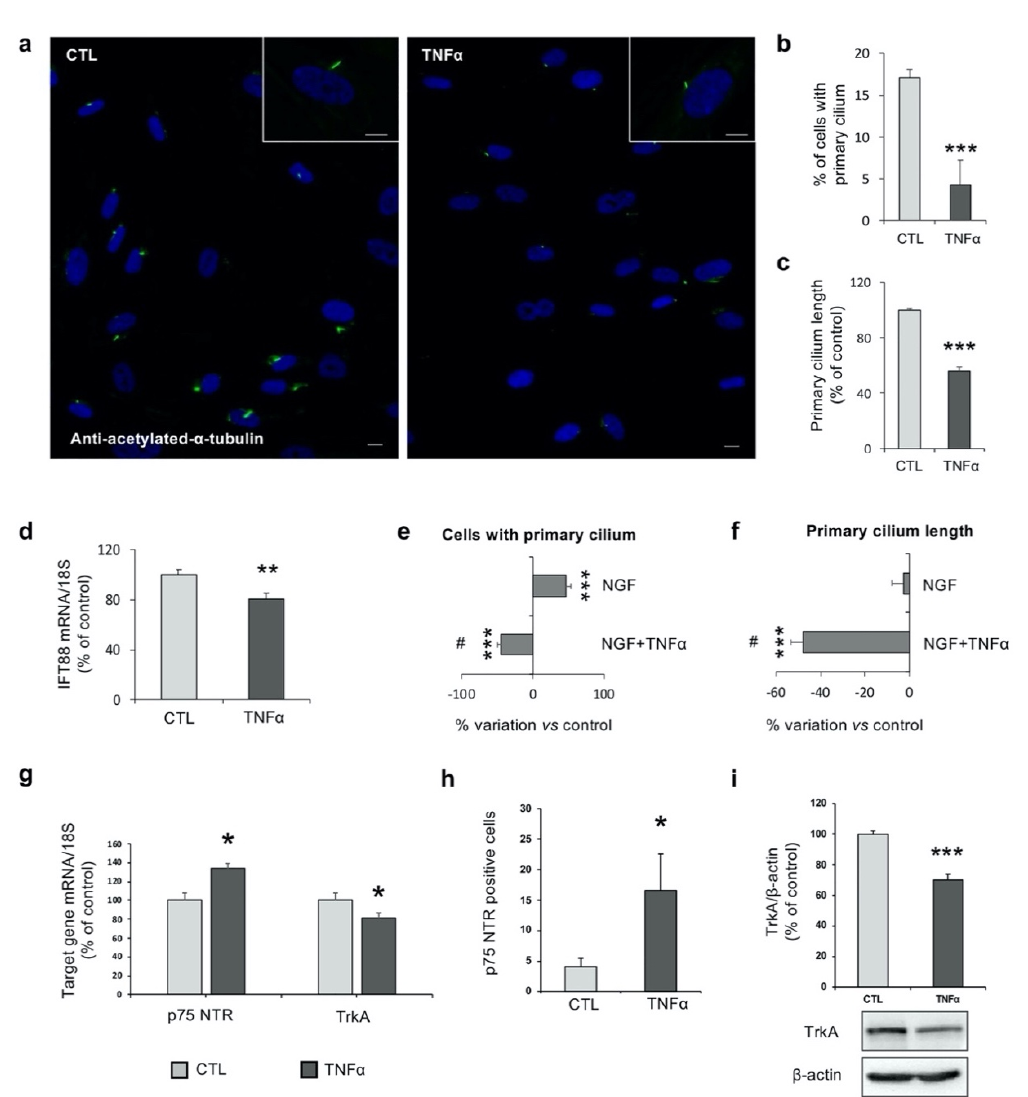
Figure 3. TNF α inhibits primary cilium formation in hfNBMs. ( a ) Representative images showing the primary cilium in untreated (CTL) or TNF α‐ treated (10 ng/mL, 24 h) hfNBMs by immunofluorescence using the specific marker acetylated α‐ tubulin (DAPI counterstained nuclei; scale bars 10 μ m). ( b ) Number of cells with a primary cilium counted in ten different fields for each condition and expressed as percentage of DAPI ‐ stained (blue) total cells. Results are reported as mean ± SEM of three separate experiments (unpaired Student’s t ‐ test; *** p < 0.001 vs . CTL; n = 30). ( c ) Evaluation of the primary cilium length performed in at least 15 cells for untreated (CTL) and TNF α‐ treated (10 ng/mL, 24 h) hfNBMs, using ImageJ NeuronJ plugin. Data are expressed as percentage of CTL and reported as mean ± SEM of three separate experiments (unpaired Student’s t ‐ test; *** p < 0.001 vs . CTL; n = 15). ( d ) IFT88 mRNA expression in untreated (CTL) and TNF α‐ treated (10 ng/mL, 24 h) hfNBMs by qRT ‐ PCR. Data are normalized over 18S ribosomal RNA subunit and reported as percentage of CTL and displayed as mean ± SEM of four separate experiments performed in triplicate (unpaired Student’s t ‐ test; ** p < 0.01 vs . CTL; n = 12). ( e ) Number of hfNBMs with a primary cilium after NGF treatment (100 ng/mL) in presence (NGF+TNF α ) or absence (NGF) of TNF α (10 ng/mL) for 24 h. Data are reported as percentage of variation of untreated cells (CTL) and displayed as mean ± SEM of four separate experiments (one ‐ way ANOVA followed by Tukey’s post hoc analysis; *** p < 0.001 vs . CTL; # p < 0.001 vs . NGF; n = 40). ( f ) Evaluation of the primary cilium length performed in at least 15 hfNBMs for NGF ‐ treated cells (100 ng/mL) in presence (NGF+TNF α ) or absence (NGF) of TNF α (10 ng/mL) for 24 h. Data are calculated using ImageJ, reported as percentage of variation of untreated cells (CTL) and displayed as mean ± SEM of three separate